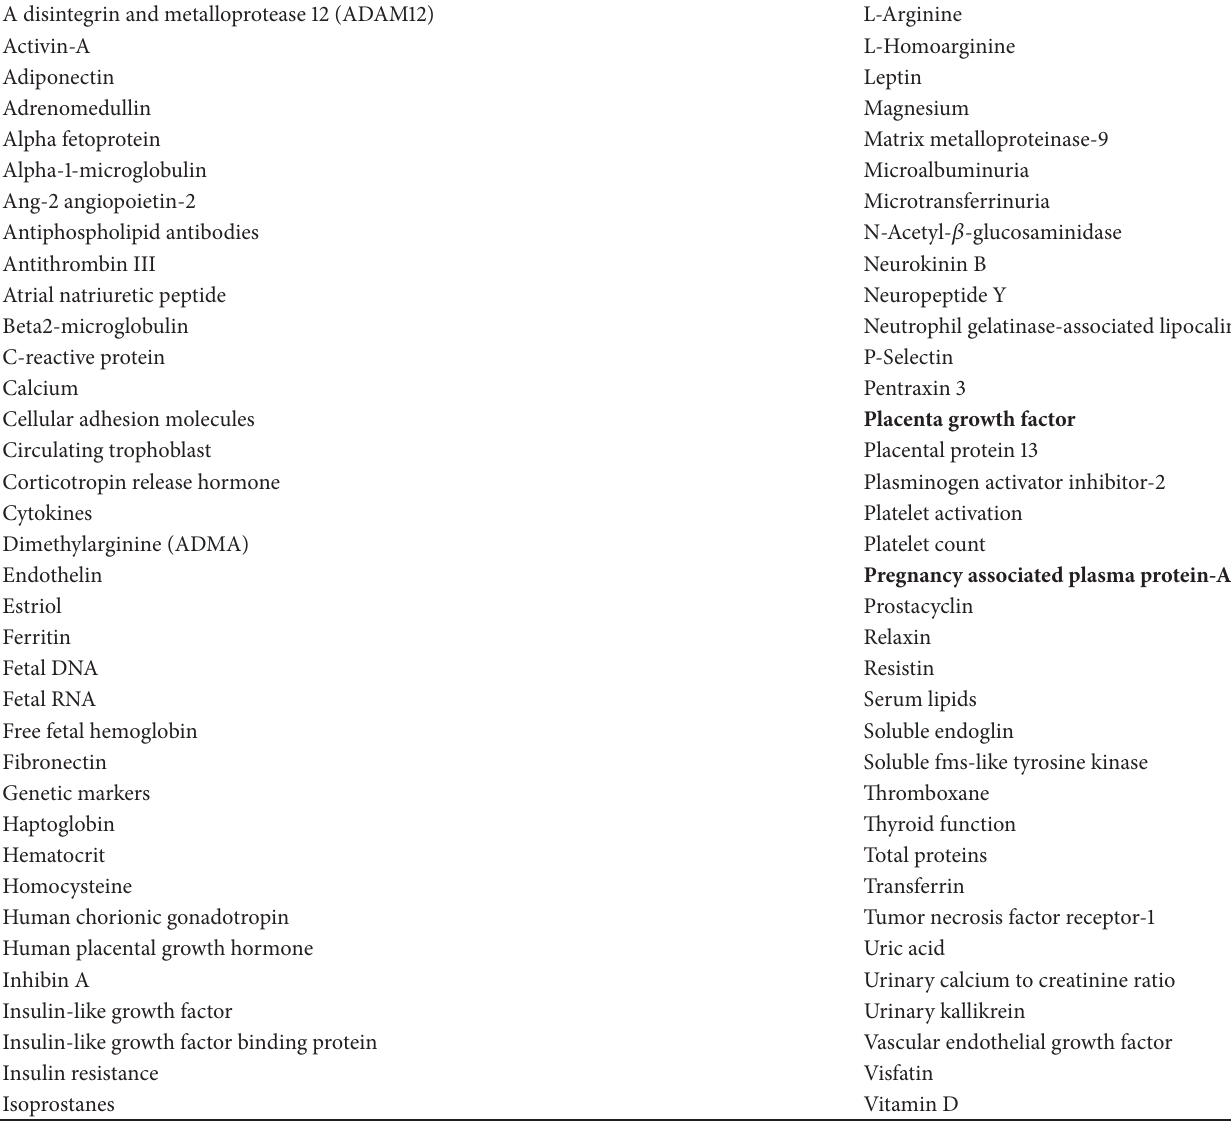
Table 3: Proposed maternal biochemical markers for the prediction of